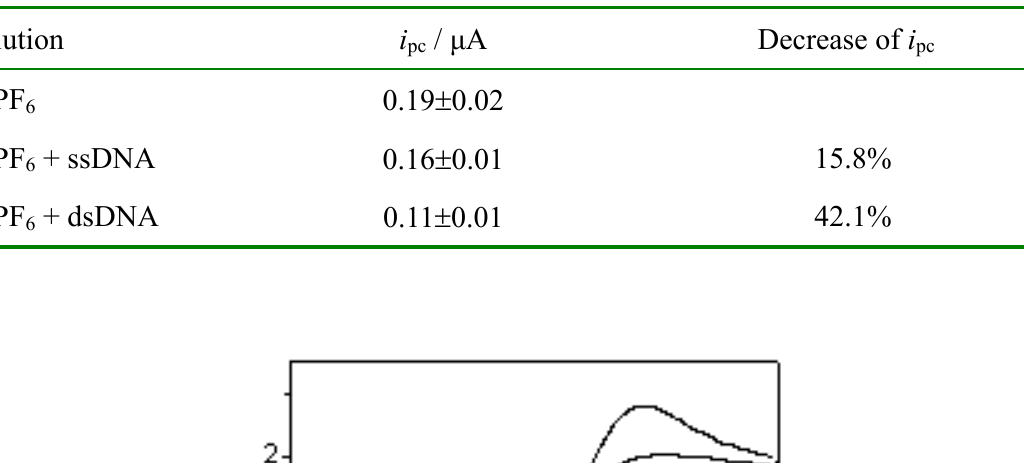
at Au electrode upon addition of 6